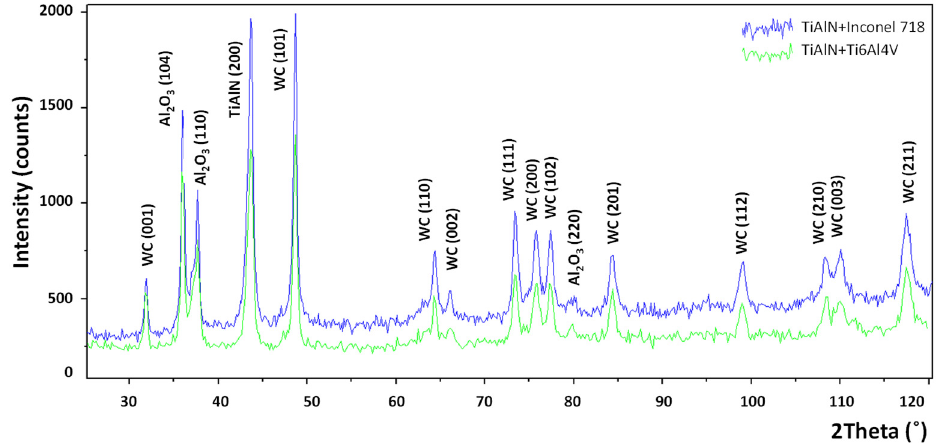
Figure 6. X-ray diffraction patterns of oxidation products generated in the diffusion tests at temperature of 900 °C during 15 min [13].